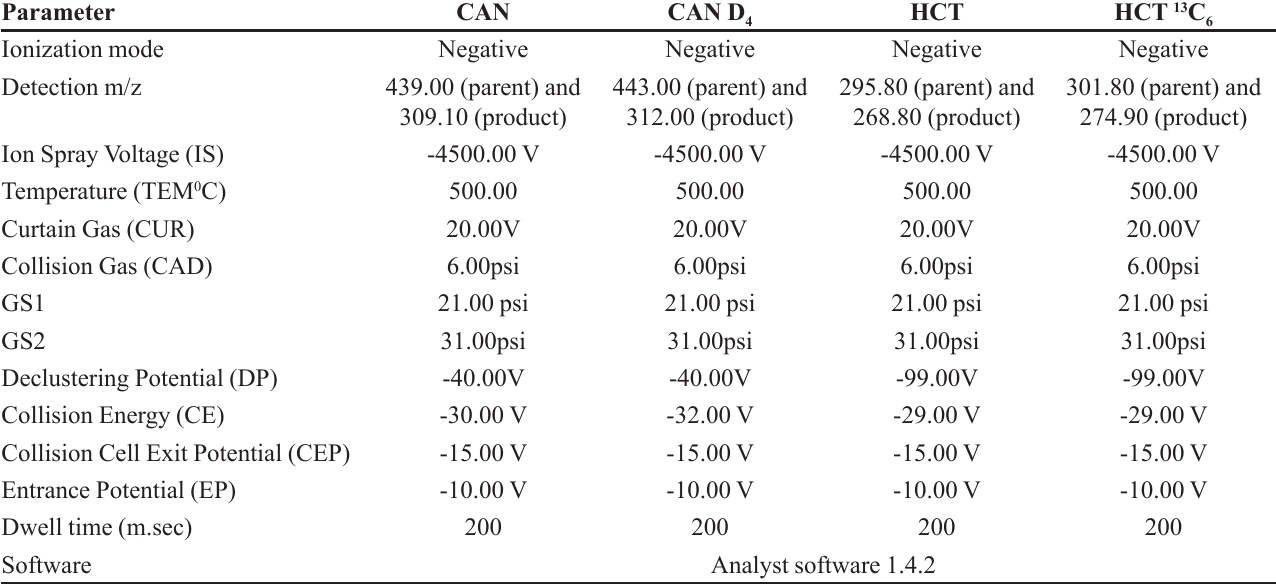
TABLE II - LC-MS/MS optimized system parameters